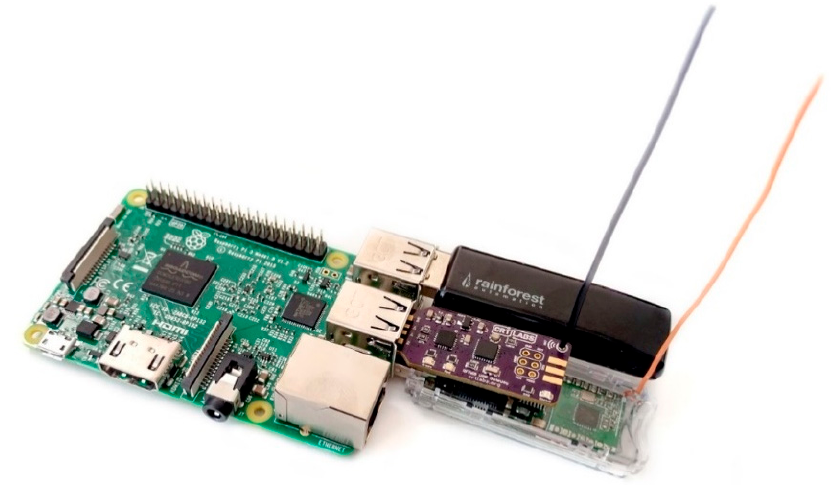
Figure 4. Raspberry Pi backhaul with gateways to connect with various wireless devices.